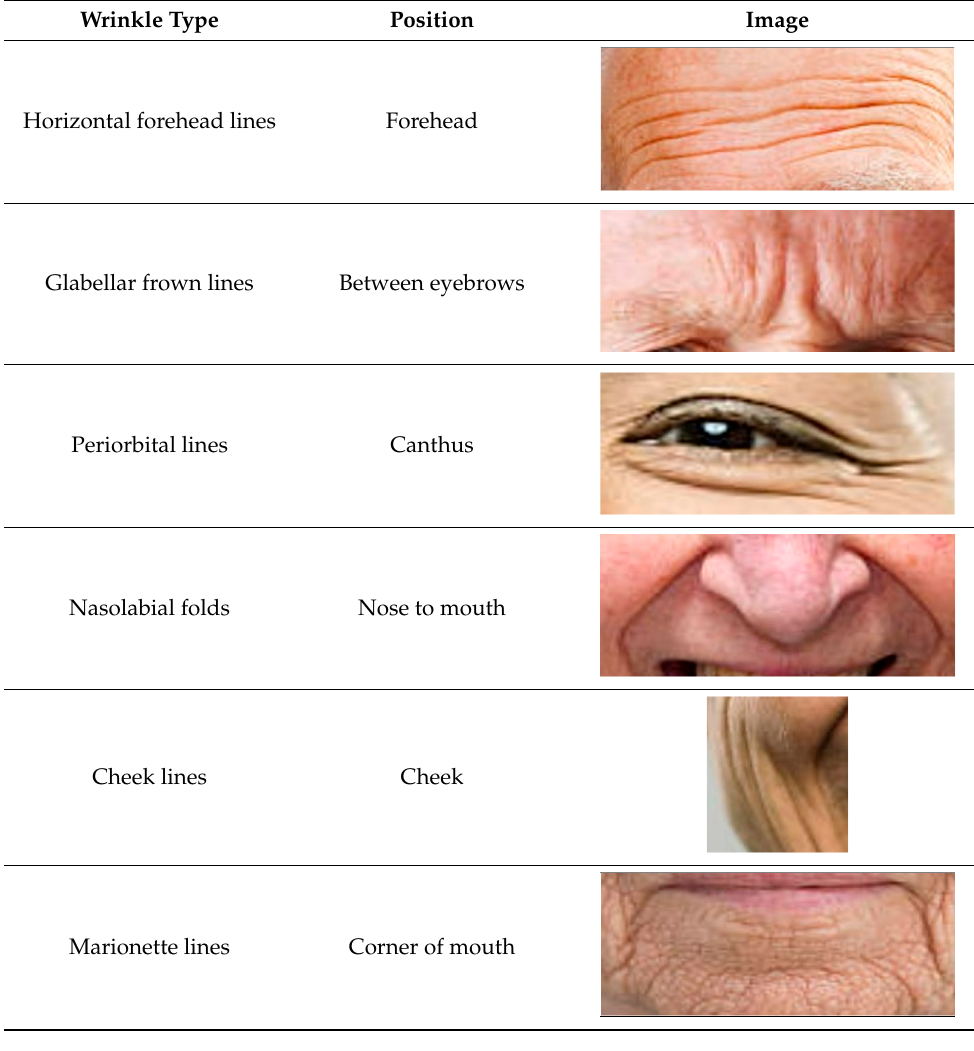
Table 4. Characteristics of ephelides and lentigines [23].